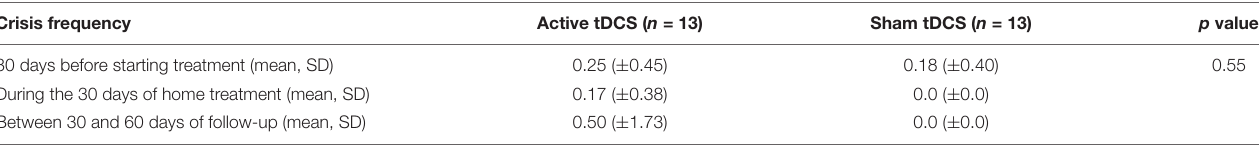
TABLE 4 | Frequency of seizures expressed as an average number of seizures in the 30 days prior to the start of treatment, in the 30 days after the start of treatment and during the 30 days after the end of home treatment. Crisis frequency Active tDCS ( n = 13) Sham tDCS ( n = 13) 30 days before starting treatment (mean, SD)